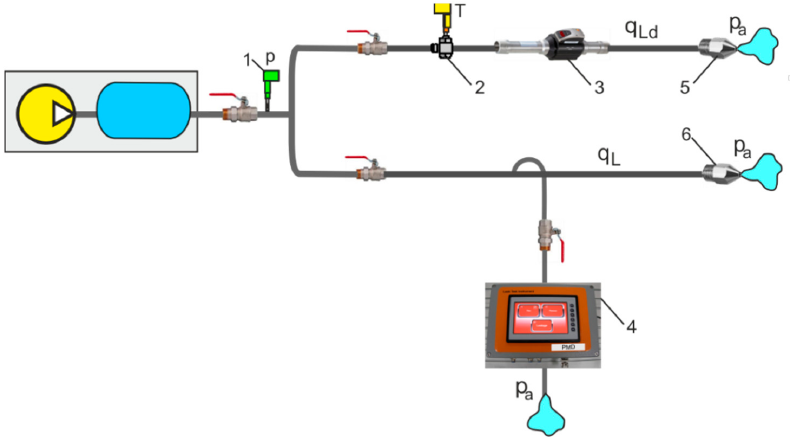
Figure 11. Schematic diagram of direct and indirect leakage flow measurement through blow noz-